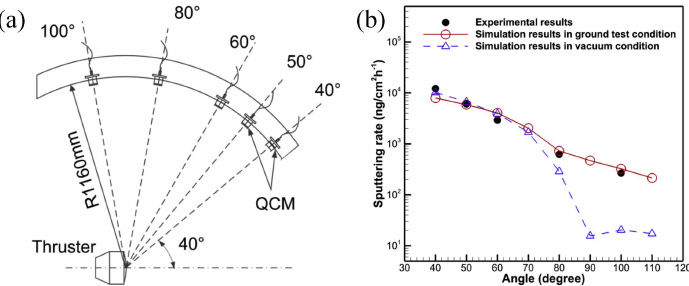
Figure 15. ( a ) Schematic of sputtering effect measurement for the LIPS-200 ion thruster. ( b ) The corresponding experimental and simulation results at different conditions